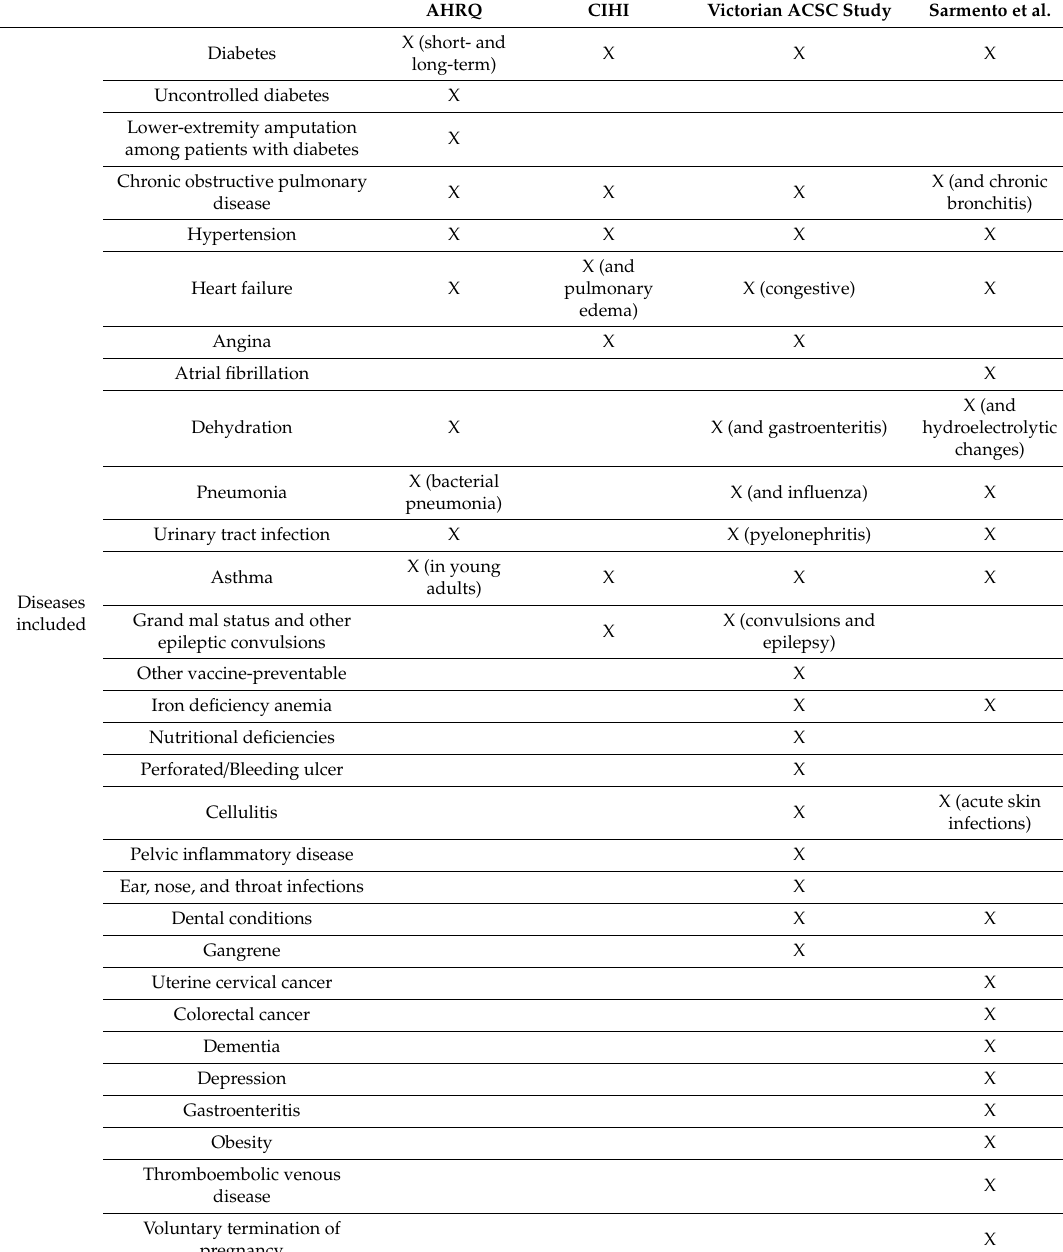
Table 1. Inclusion and Exclusion Criteria of Each Ambulatory Care Sensitive Conditions List. AHRQ CIHI Victorian ACSC Study Sarmento et